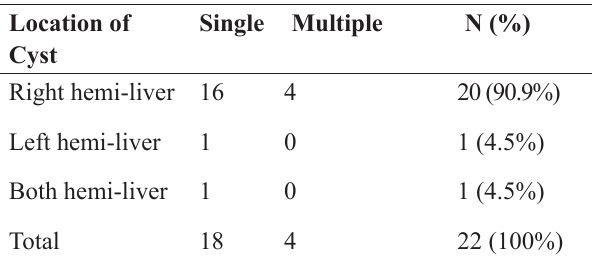
Figure 1. Distribution of Gender